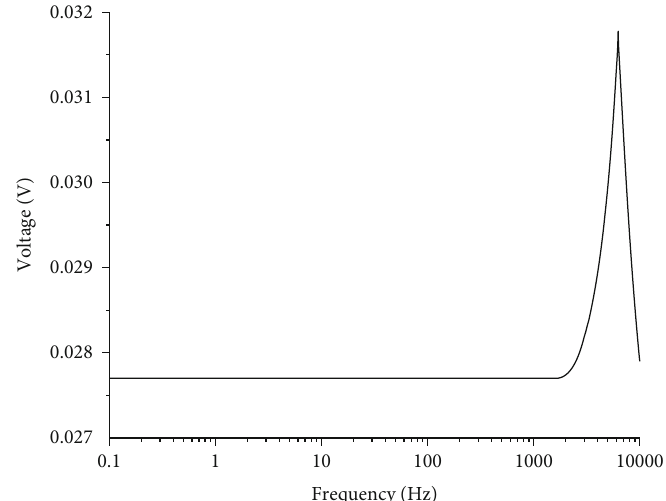
Figure 9: Voltage frequency diagram of the piezoelectric